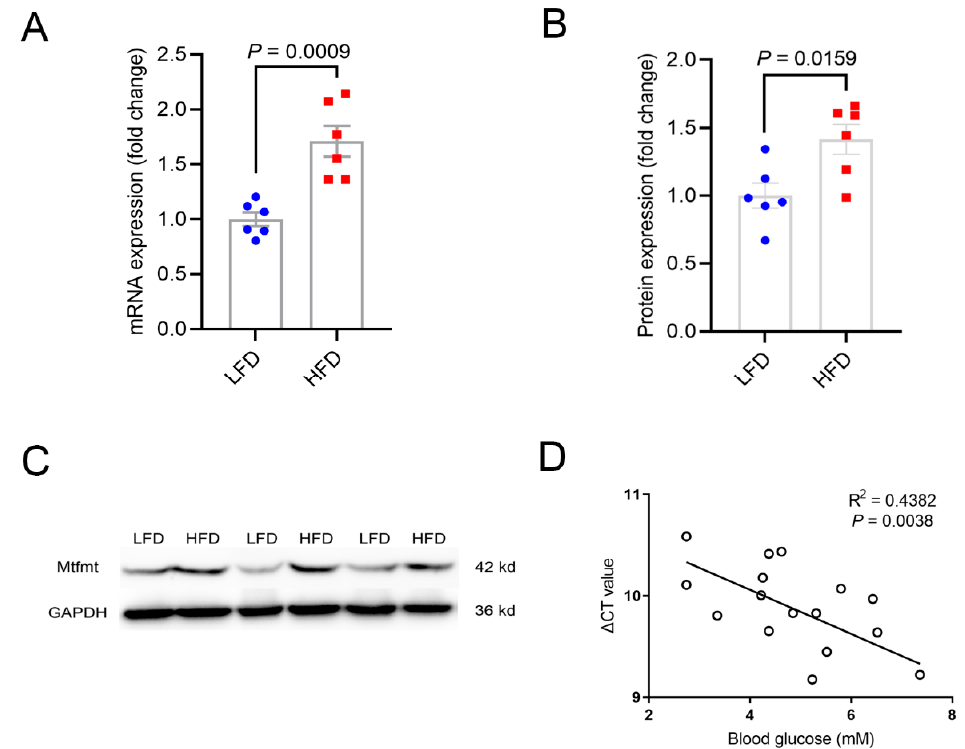
Figure 1. Expression levels of mitochondrial methionyl-tRNA formyltranse ( Mtfmt ) were correlated with diet and glucose levels. ( A , B ) Expression of Mtfmt in the livers of low-fat-diet (LFD) and high-fat-diet (HFD) male mice. ( C ) Mtfmt protein expression in the livers of LFD and HFD male mice. ( D ) Correlation analysis between Mtfmt gene expression and fasting glucose levels.